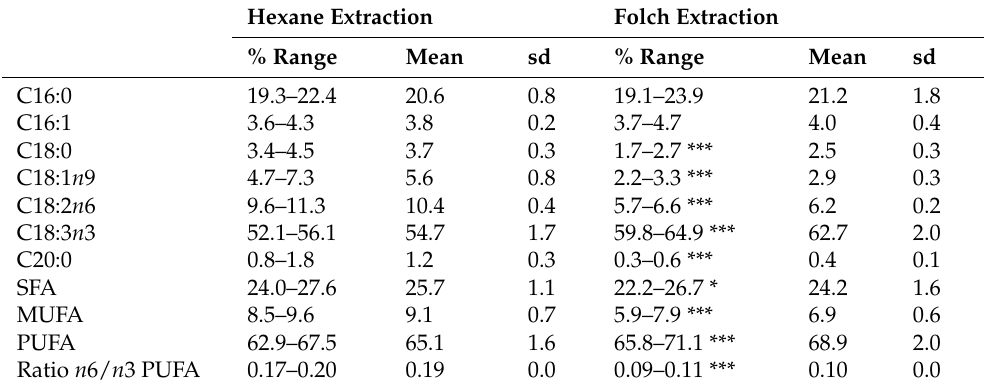
Table 4. Comparison between the % fatty acid composition obtained with hexane extraction and with Folch extraction: % range in the 10 samples analysed, mean and standard deviation (sd). Hexane